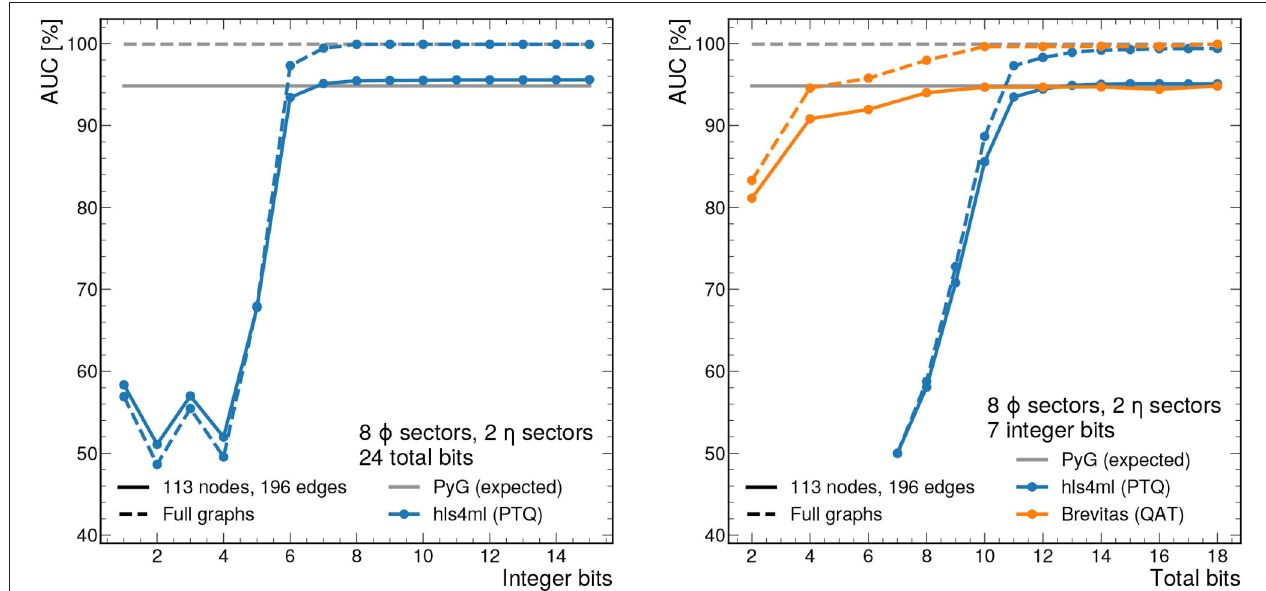
FIGURE 7 | AUC values as a function of the integer bit width with total bit width fixed to 24 (left) and total bit width with integer bit width fixed to 7 (right) . Either the full sectorized 2GeV graphs (dashed line) or those truncated at 113 nodes and 196 edges (solid line), corresponding to the 95% percentile graph size, are used as input. The performance is evaluated with 1,000 graphs from train_2 . With precision greater than ap_fixed<12,7> , the AUC closely approximates the full floating point model for the same graphs.